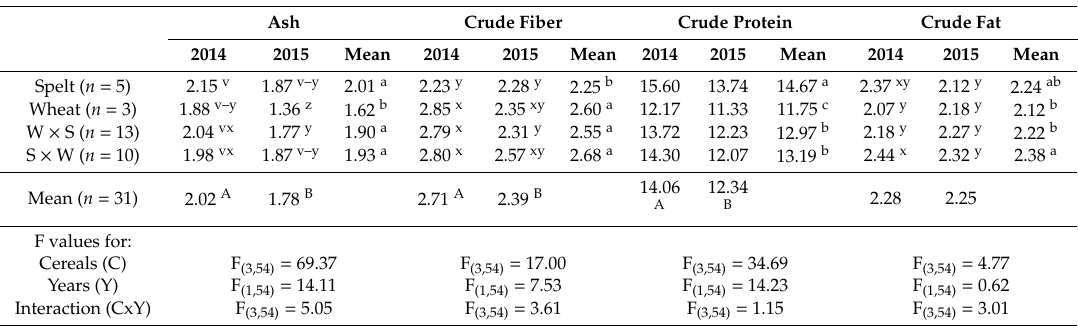
Table 3. The content of ash, dietary fiber, crude protein and crude fat (in percent of dry matter) in the grains of the hybrids and their parental forms in 2014 and 2015.